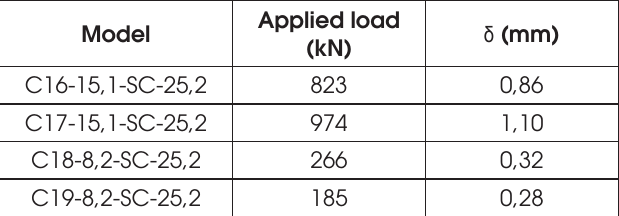
Load applied and relative slip of loss of natural